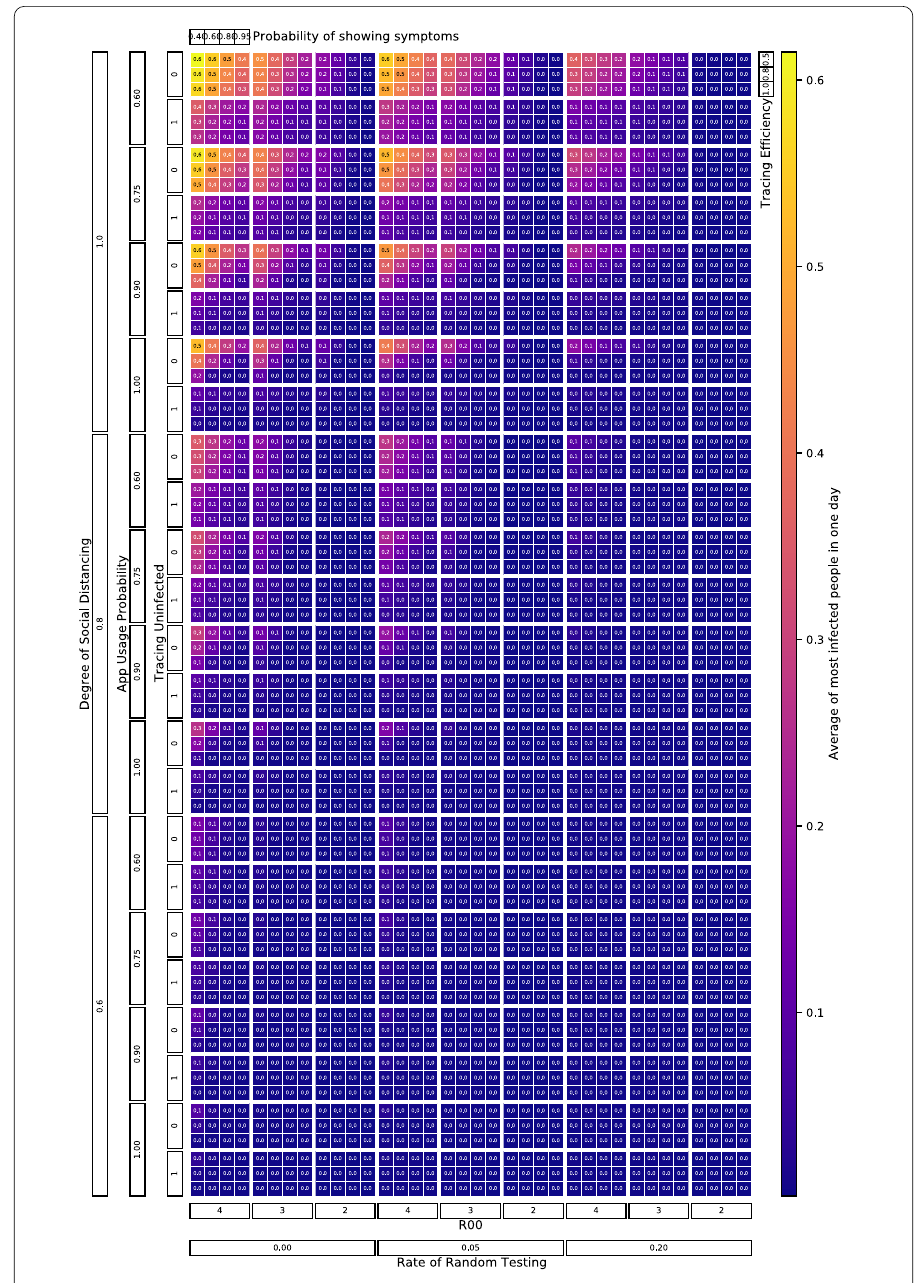
Figure 27 The fraction of the population that is sick on the day when most people are sick is shown for all combinations of parameters in the default parameter scan (black font color in Tab. 1)